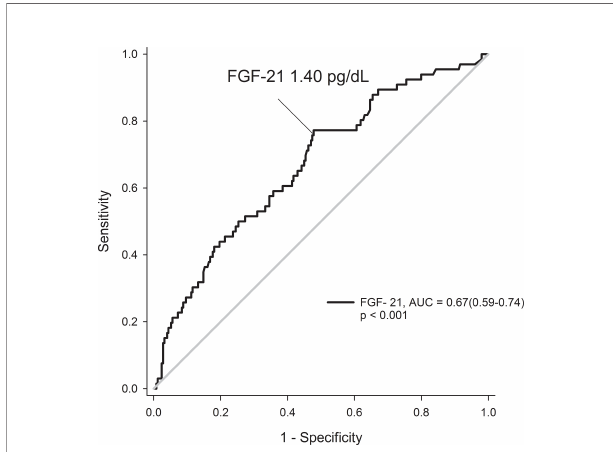
FIGURE 4 | Receiver operating characteristic curves for prediction of renal events by FGF-21 levels in patients with type 2